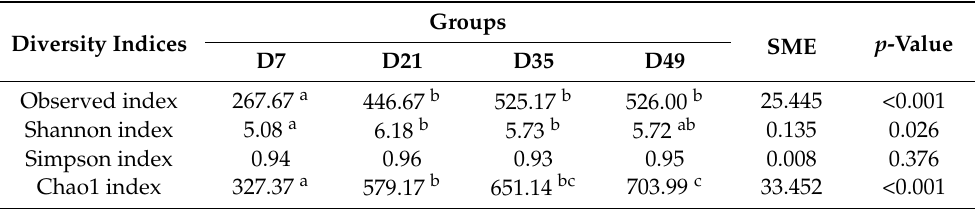
Figure 1. Microorganism rarefaction curves based on Observed ( a ) indices were used to assess the depth of coverage of each sample; each sample was distinguished by different colored lines. ( b ) Venn diagrams for Gut microbial operational taxonomic unit (OTU) compositions (D7, 7 days after birth; D21, 21 days after birth; D35, 35 days after birth; D49, 49 days after birth. At each time point, samples were obtained from six lambs). Table 2. Fecal microbial richness and diversity